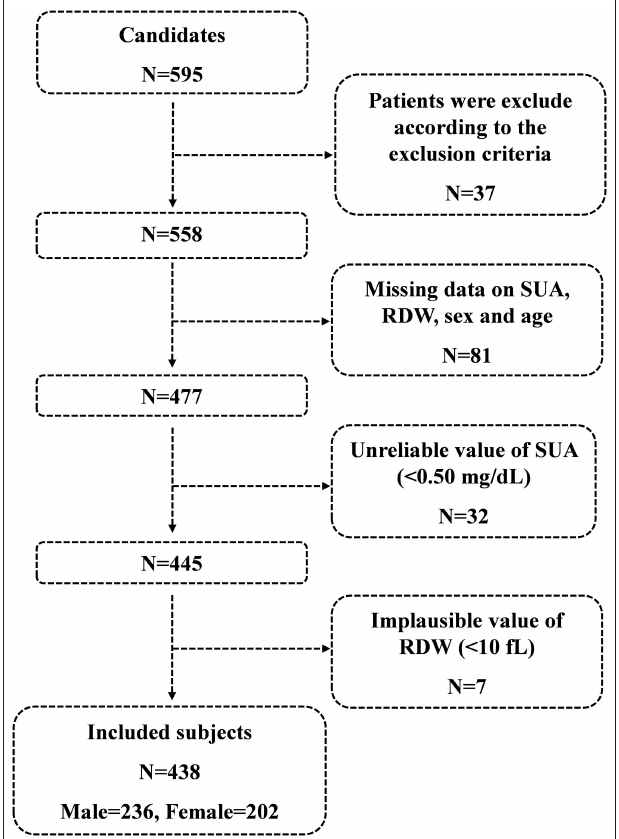
FIGURE 1 | Flowchart of this